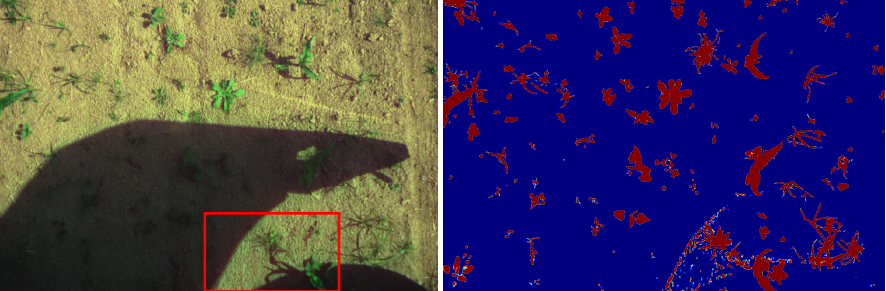
Figure 14. Vegetation/soil discrimination issue with abrupt transition between shadow and light.